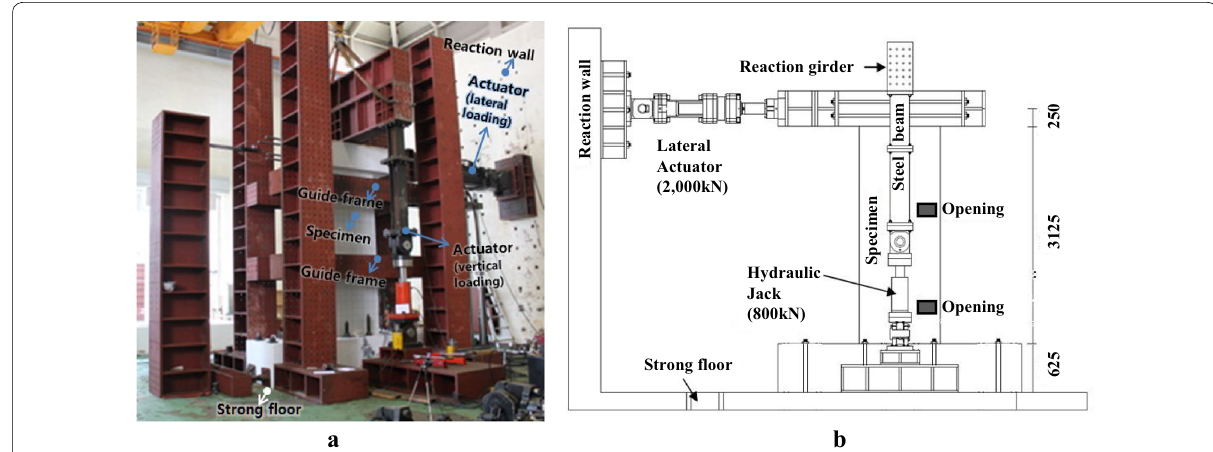
Fig. 5 Test setup. a Test setup picture, b test setup plan